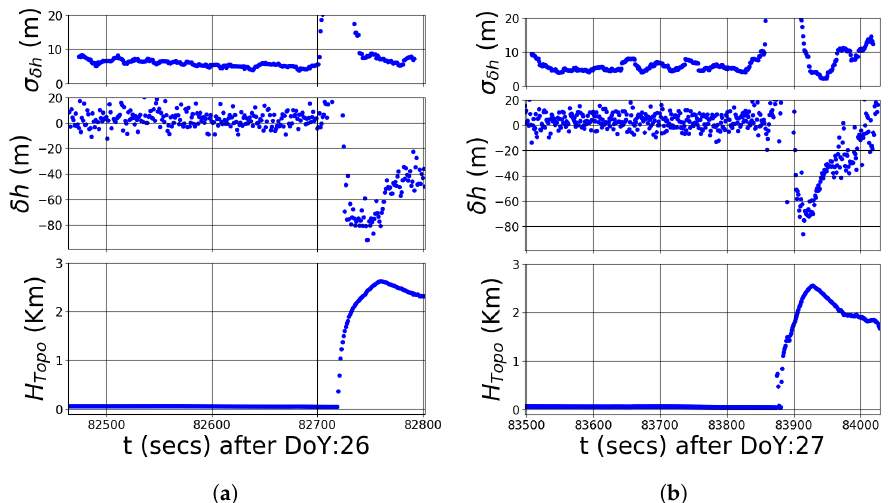
Figure 7. In each column we have represented from bottom to top (1) the topography associated to each track H Topo , (2) the estimate of the apparent the height relative to the a priori model δ h apparent , and (3) its standard deviation σ δ h . ( a ) 26 January 2015. ( b ) 27 January